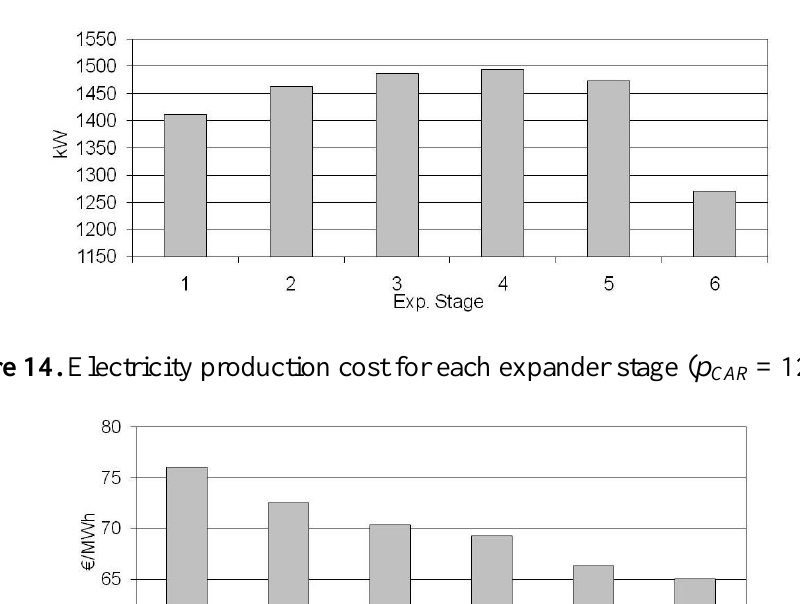
Figure 13. Power produced by each expander stage ( p